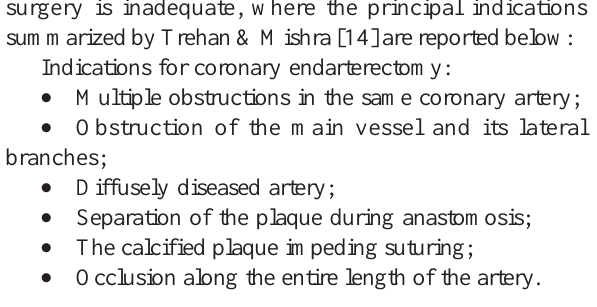
Table 4. Experience of departments with coronary